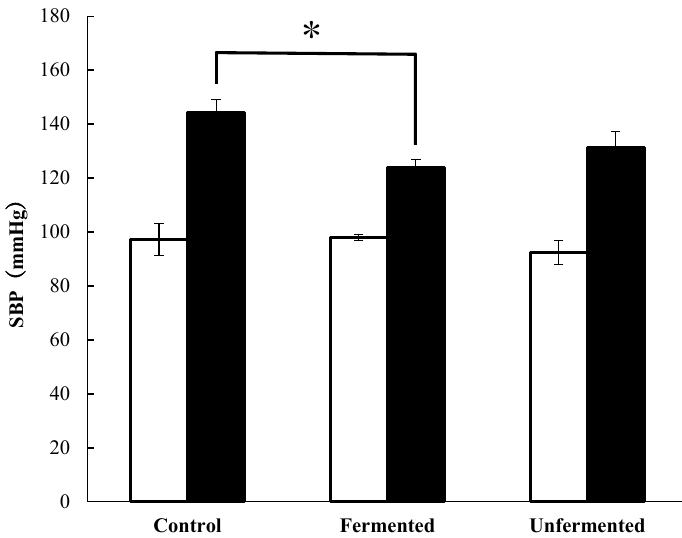
Figure 2. Systolic blood pressure results before and after AI administration in ddY mice loaded with AI, p < 0.05 Fermented vs. Control (*); The data represented the mean values ± standard error ( n = 5).